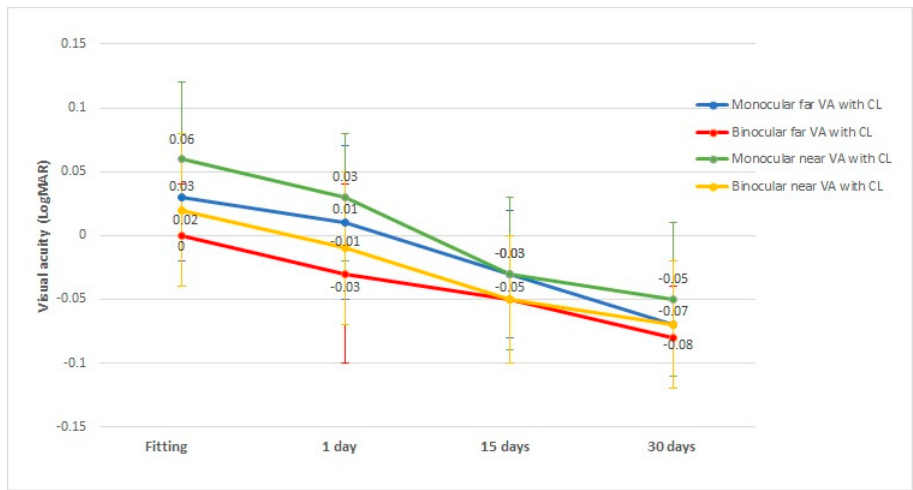
Figure 1. Changes in the visual acuity with contact lens measured at the different visits of the current clinical study. Abbreviations: CL, contact lens; VA, visual acuity.